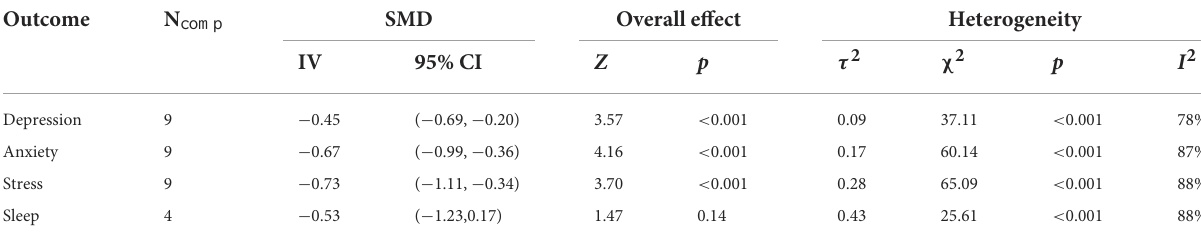
TABLE 3 Comparative effectiveness between treated and control group in terms of depression, anxiety, stress, and quality of sleep. Outcome N comp SMD Overall effect Heterogeneity